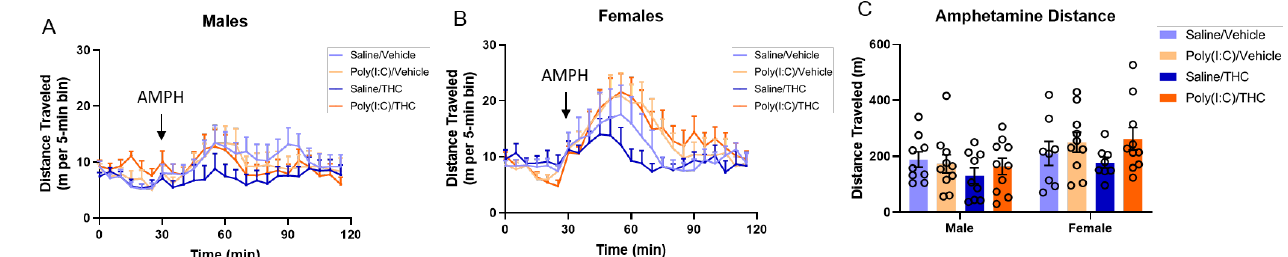
Figure 2. Amphetamine hyperlocomotion. ( A , B ) Distance traveled by male ( A ) and female ( B ) mice following saline (0–30 min) and d-amphetamine (AMPH, 2.5 mg/kg, 30–120 min) reported in 5 min bins. ( C ) Total distance traveled by mice during the 90 min following d-amphetamine injection. One female in the saline/THC group was removed from analysis as a statistical outlier (Rout, Q = 1%). Bar height represents the mean, vertical lines the SEM.